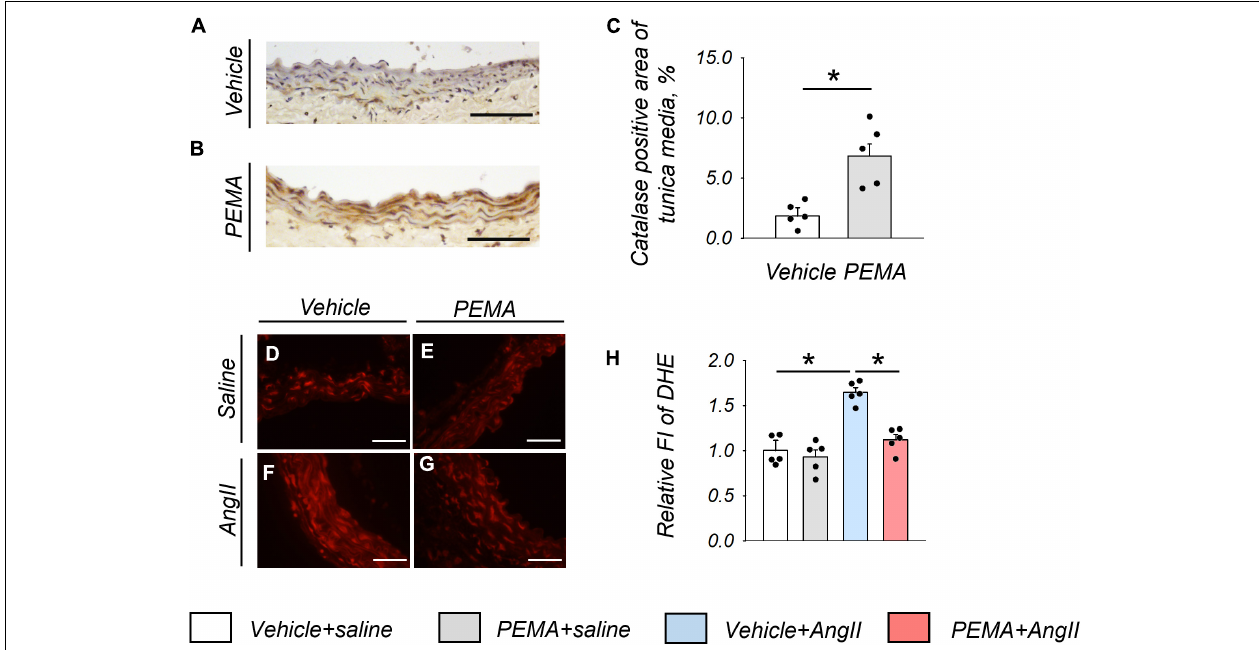
FIGURE 4 | Catalase expression and the reduction in reactive oxygen species (ROS) in the aortic wall at 1 week after angiotensin (AngII) infusion. Representative findings of anti-catalase staining (A,B) and quantitative evaluation of catalase expression (C) in the suprarenal aorta from vehicle-treated saline-infused mice and in pemafibrate (PEMA)-treated saline-infused mice ( n = 5 per group, performed in duplicate). Representative results of dihydroethidium (DHE) staining (D–G) and relative fluorescence intensity (FI) of DHE staining ( n = 5 per group, performed in duplicate) (H) in the suprarenal aorta extracted from vehicle-treated saline-infused, PEMA-treated saline-infused, vehicle-treated AngII-infused, and PEMA-treated AngII-infused mice. Data are expressed as the mean ± standard error of the mean. All analyses were performed using analysis of variance and Bonferroni corrections. * p < 0.01. Scale bar = 50 µ